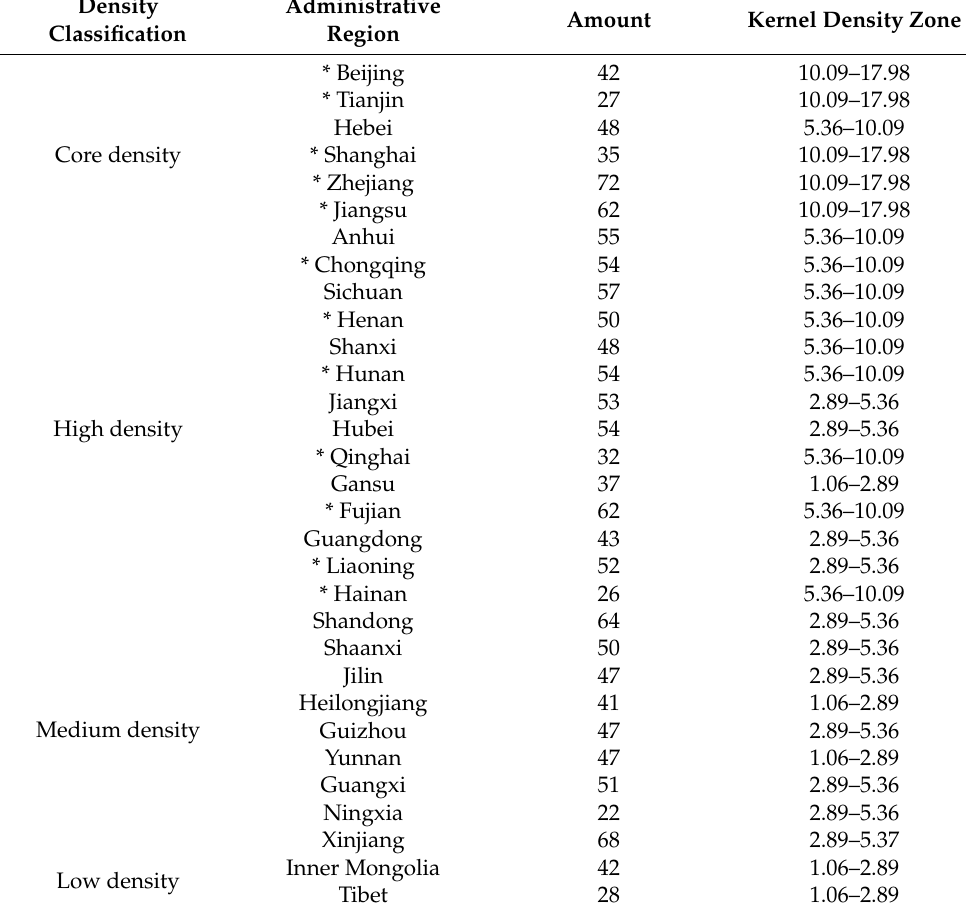
Table 2. Kernel density analysis of beautiful leisure villages in